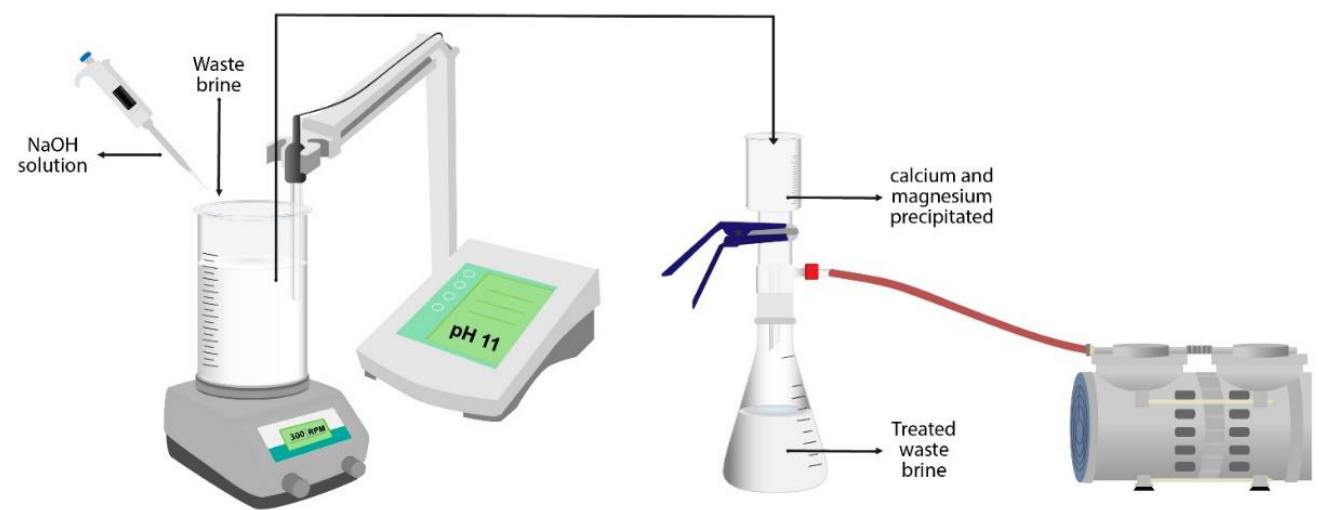
Figure 1. Experimental unit used in the waste brine treatment.